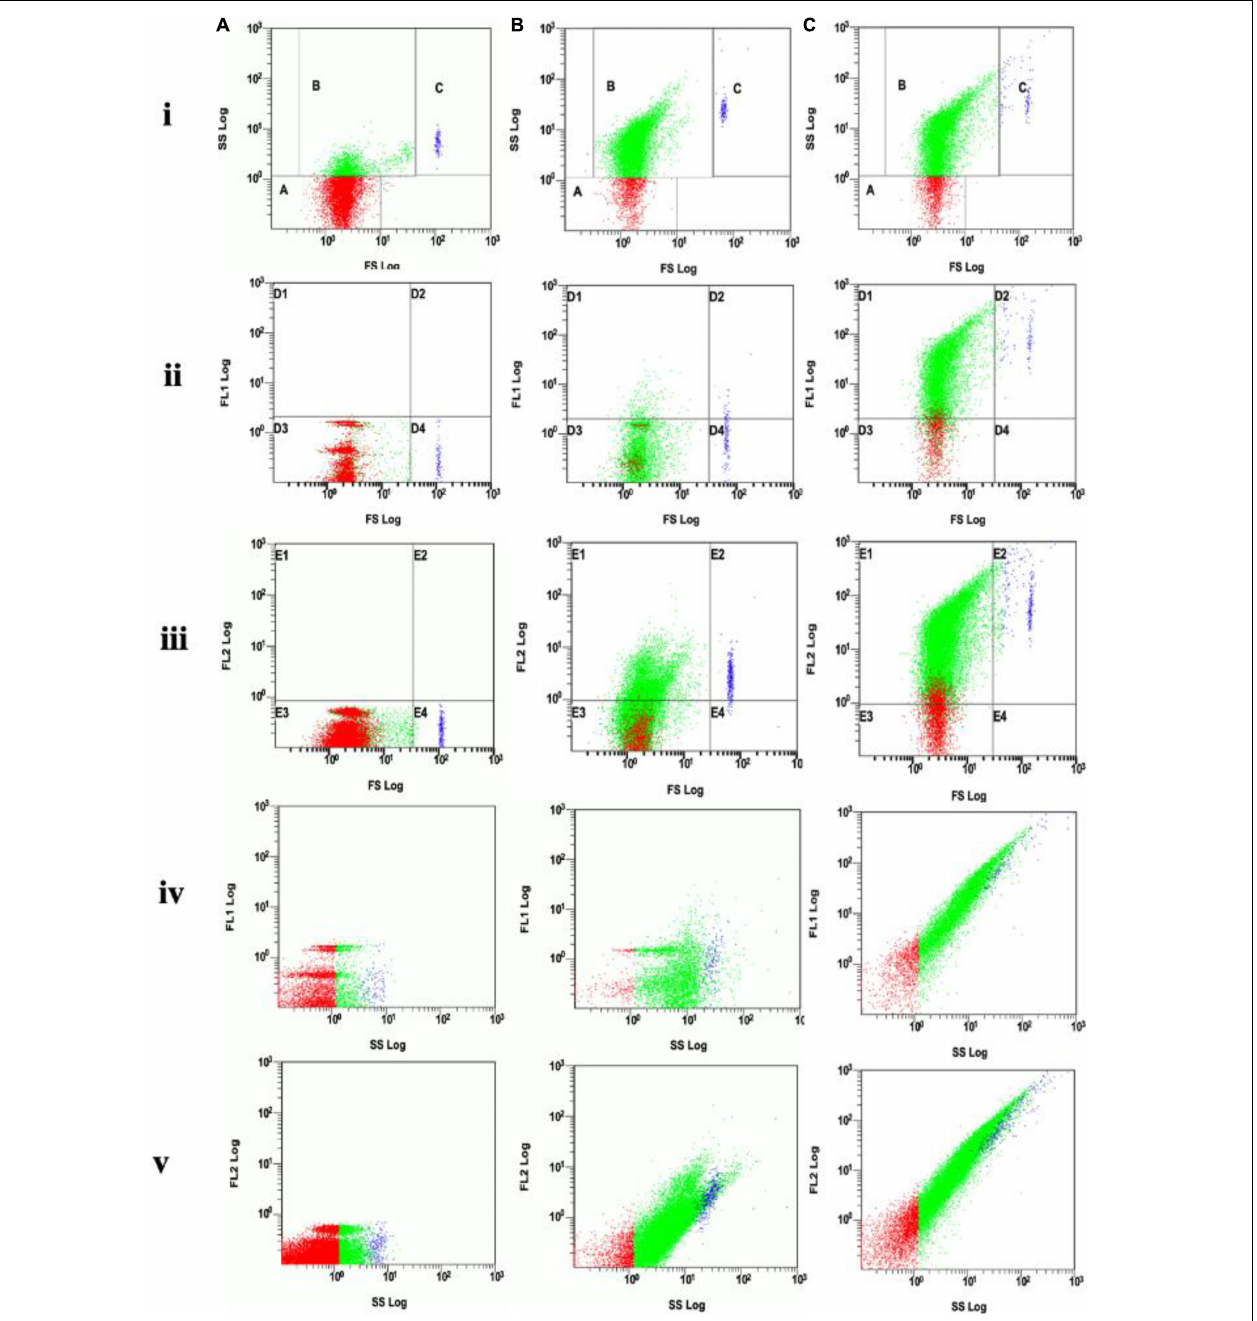
FIGURE 4 | (A) Analysis of EVs without electroporation (control). (B) Analysis of DNA-electroporated extracellular vesicles (EVs) stained with lipophilic Dil fluorescent dye, the EVs showing positive fluorescence signal was distributed in gates E1 and E2 of the FL2 channel. (C) Analysis of DNA-electroporated EVs double-stained with both Picogreen and lipophilic Dil fluorescent dyes. EVs showing positive fluorescence signal distributed in gates D1 and D2 in the FL1 channel (for Picogreen) and in gates E1 and E2 in the FL2 channel (for Dil). On each row, (i) the forward scatter (FS) vs. side scatter (SS), gate A containing dust/noise, gate B containing EVs and gate C containing large or aggregated EVs, (ii) FL1 vs. FS, (iii) FL2 vs. FS, (iv) FL1 vs. SS, and (v) FL2 vs.